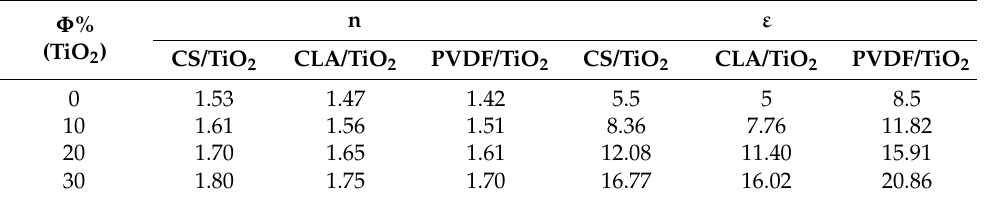
Table 3. Refractive index and dielectric constant of CS/TiO 2 , CLA/TiO 2 and PVDF/TiO 2 nanocom- posites as function of volume fraction of TiO 2 NPs.